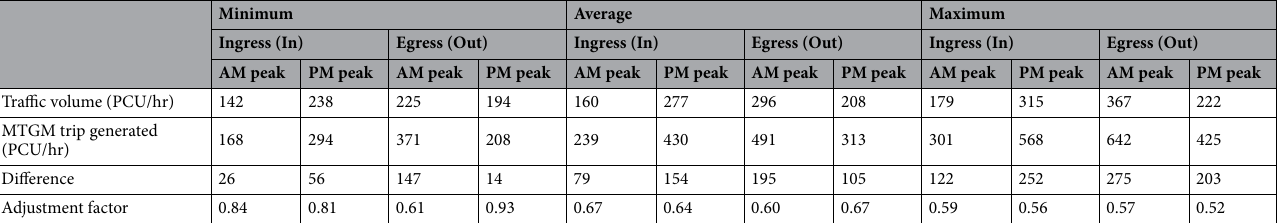
Table 6. Traffic volume, MTGM trip generated, and adjustment factor at 3 rd MXD site (Site C).